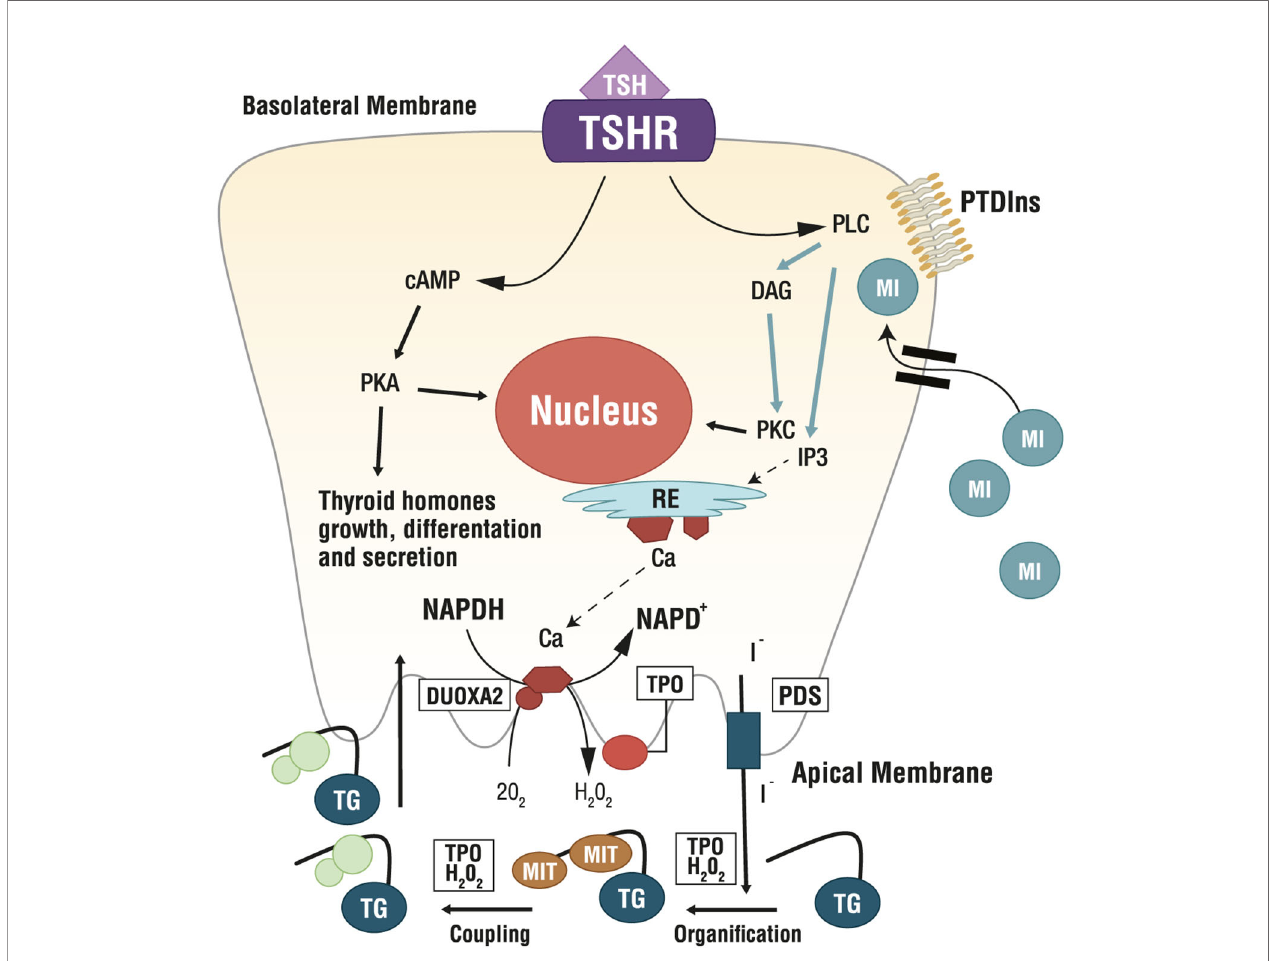
FIGURE 3 | Role of Myo-Inositol in physiology of thyroid. Ca, calcium; cAMP, cyclic adenosine monophosphate; DAG, diacylglycerol; DUOXA2, dual oxidase A 2; ER, endoplasmic reticulum; H 2 O 2 , hydrogen peroxide; I - , iodine; IP3, inositol triphosphate; MI, myo-inositol; MIT, monoiodotyrosine; NAPD+/NADPH, nicotinamide adenine dinucleotide phosphate; O 2 , oxygen; PDS, pendrin; PKA, protein kinase A; PKC, protein kinase C; PLC, phospholipase C; PTDIns, phosphatidylinositol; TG, thyroglobulin; TSH, thyroid stimulating hormone; TSHR, TSH Receptor; TPO,